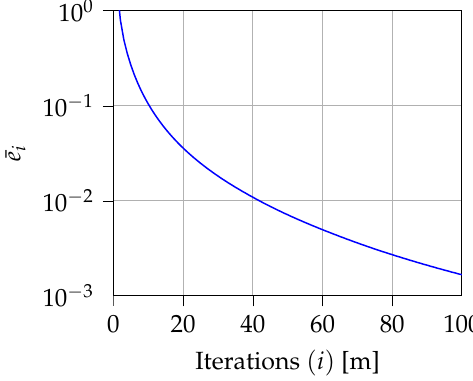
Figure 3. Mean error versus number of